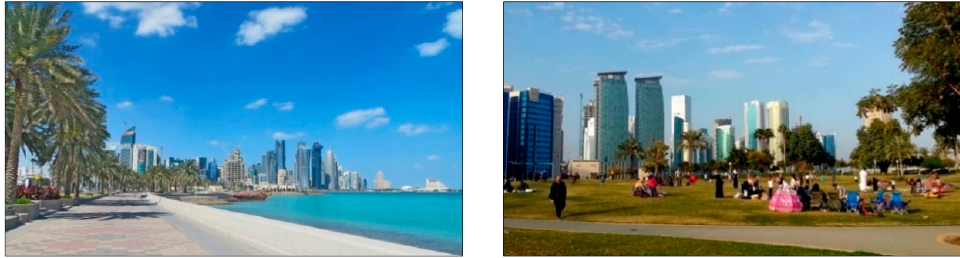
Figure 14. ( left ) Doha’s Corniche; ( right ) Sheraton Park (Sources: DohaLife. Adapted from [35]).